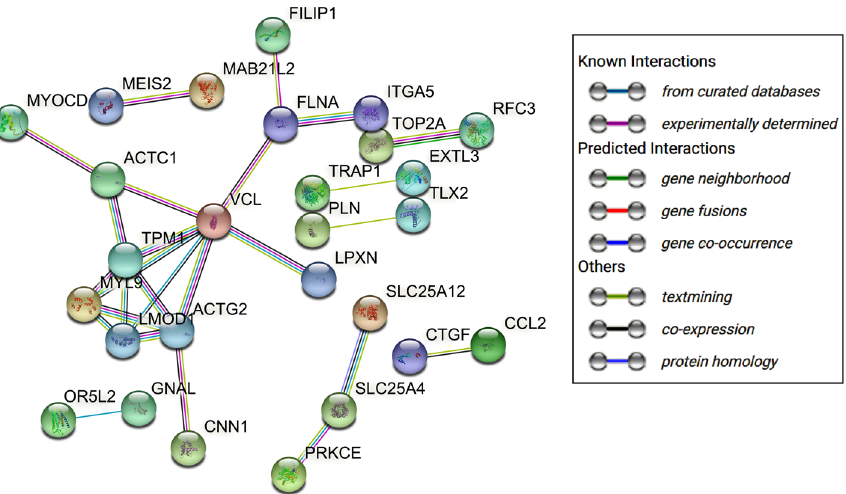
Figure 6. Protein–Protein interaction (PPI) network among the 126 salient genes. At a confidence score of 0.700, the figure exhibits major interactions among the protein-coding genes as node and various interactions as edges. The colored nodes are query proteins with 3D structures (if any) inside the node and edge color represents evidence as an indicator of interactions among the proteins. The isolated nodes were removed from the